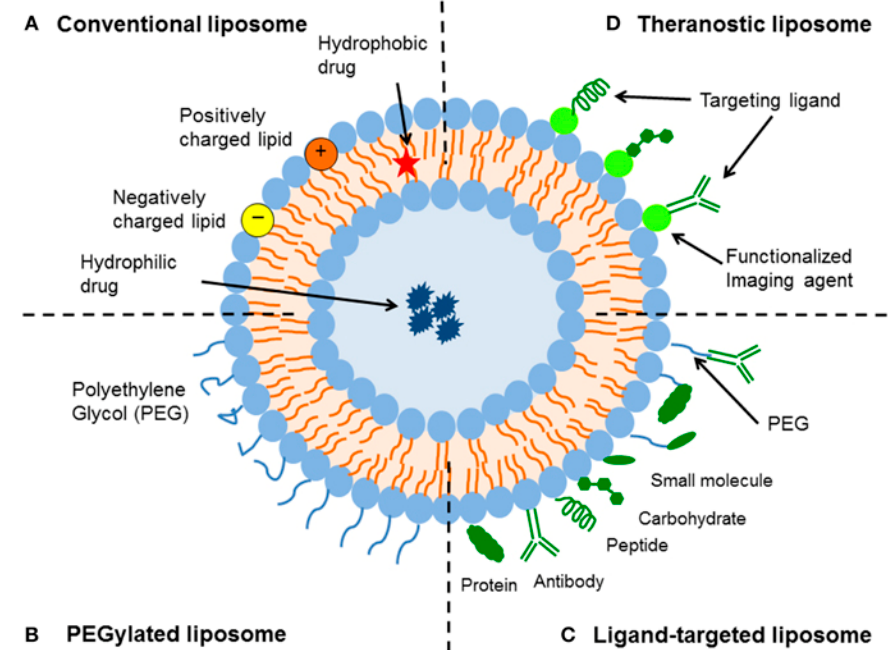
Figure 1. Schematic representation of the different types of liposomal drug delivery systems. ( A ) Conventional liposome: liposome composed of a lipid bilayer of anionic, cationic or neutral phospholipids and cholesterol. Drugs can be incorporated both in the bilayer (hydrophobic drugs) and in the aqueous core (hydrophilic drugs). ( B ) PEGylated liposomes: lipid bilayer endowed with a PEGylated phospholipid to make the nanosystem stealth and sterically stable. ( C ) Ligand ‐ targeted liposome—Liposomes can be used for specific targeting by attaching ligands (e.g., antibodies, peptides, and carbohydrates) to its surface or to the terminal end of the attached PEG chains. ( D ) Theranostic liposome—A lipid bilayer bearing at the same time an imaging and a therapeutic agent.